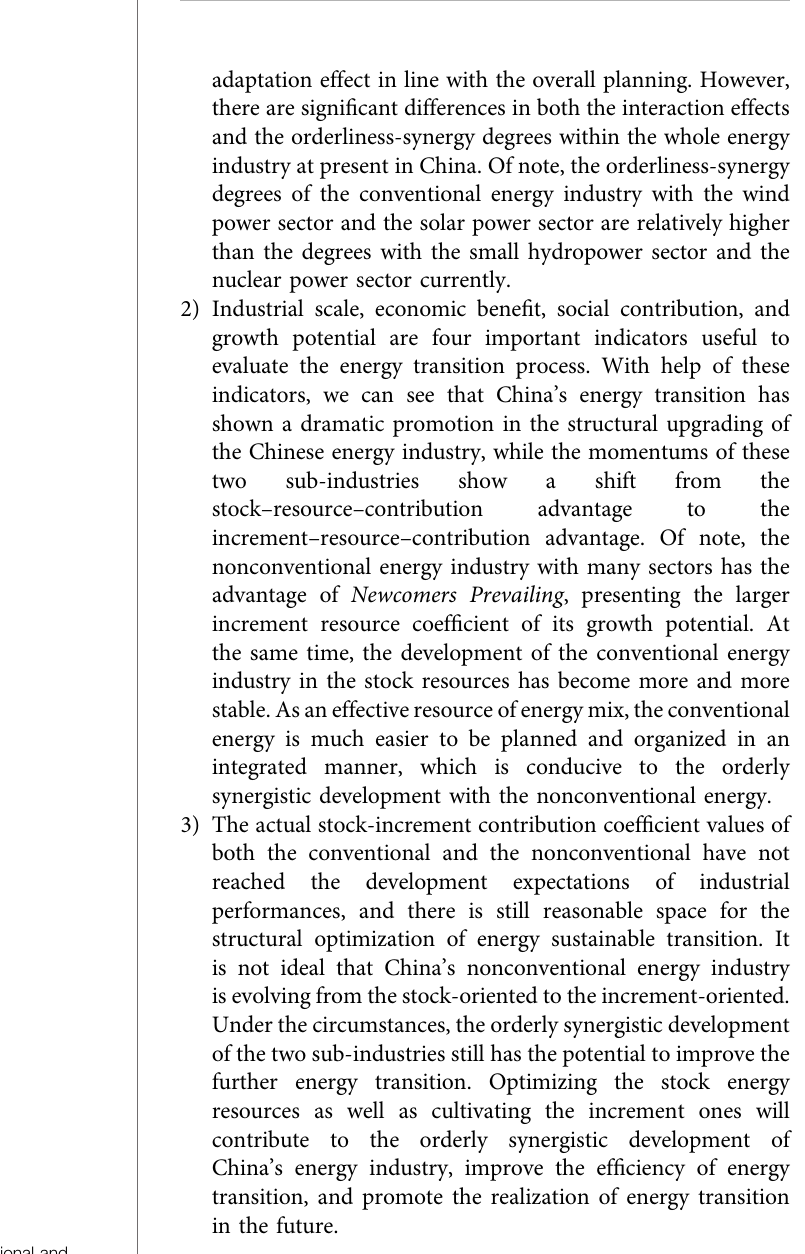
FIGURE 2 | Orderliness-synergy degree OS t cn of the conventional and the nonconventional in 2011 – 2018. (A) Orderliness-synergy degree in 2011, (B) orderliness-synergy degree in 2012, (C) orderliness-synergy degree in 2013, (D) orderliness-synergy degree in 2014, (E) orderliness-synergy degree in 2015, (F) orderliness-synergy degree in 2016, (G) orderliness- synergy degree in 2017, and (H) orderliness-synergy degree in 2018.